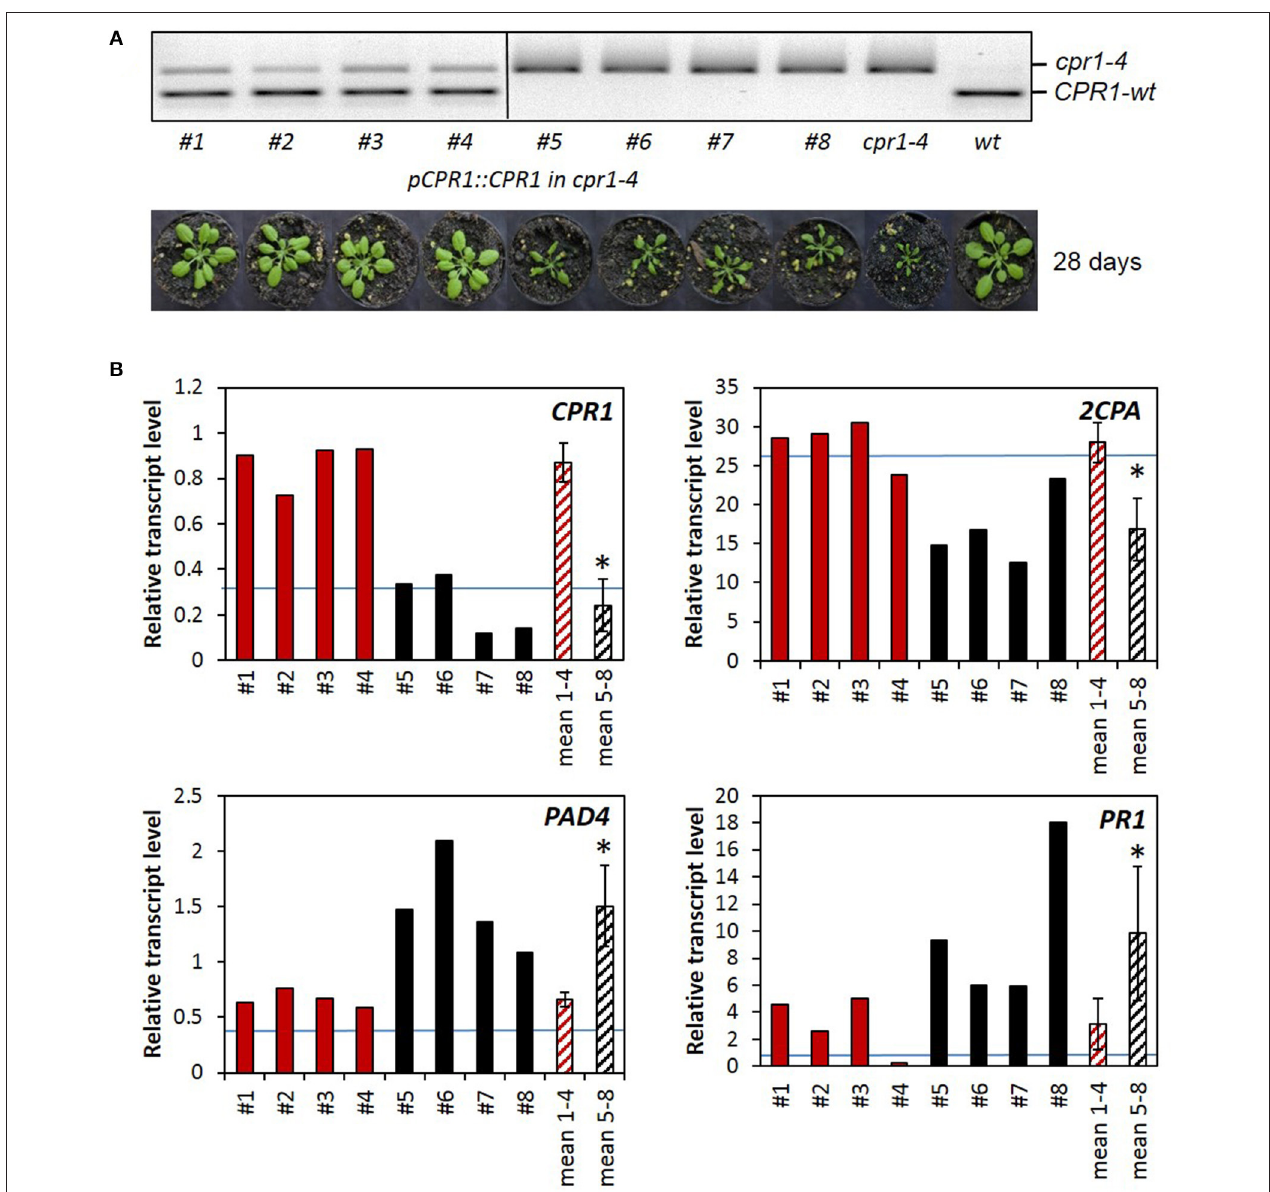
FIGURE 3 | Complementation analysis. (A) CAPS-marker analysis and habitus of 4 cpr1-4 lines expressing the pCPR1::CPR1 complementation construct (#1-#4), 4 non complemented lines out of the same segregating T 2 population (#5-#8), untransformed cpr1-4 and Col-0 wildtype plants. The mutant allele gives a 391 bp fragment. From the wildtype allele, a 233 bp long FokI cleavage product is shown. (B) Relative transcript levels in 28-day-old plants: qRT-PCR was performed in triplicates with RNA isolated from single plants. For the two sets of 4 biological replicates, the means and standard deviations were calculated (mean 1-4 and mean 5-8) and the data sets were compared for significance of difference by pairwise t -test ( P < 0.05; asterisks mark significant differences between the two mean values). The blue line marks the expression intensity of the respective gene in Arabidopsis thaliana wildtype plants.